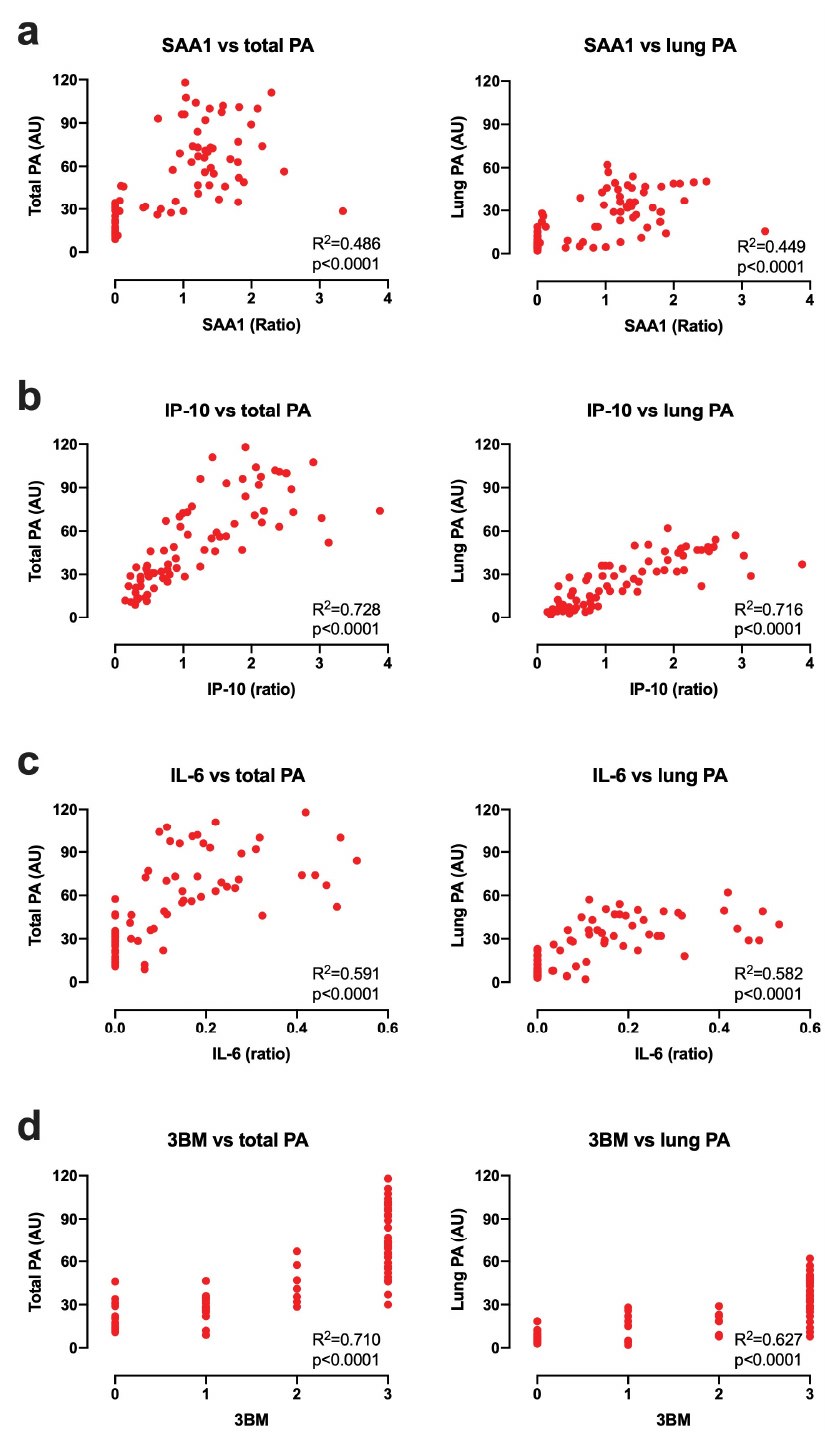
Figure 3. Correlation between SAA1, IP-10, and IL-6 levels and total/ lung pathology score at the endpoint. ( a ) SAA1, ( b ) IP-10, and ( c ) IL-6 levels ( x -axis) were measured by UCP-LFA in serum from MTB Erdman infected rhesus macaques ( n = 75, see Figure 1). Tuberculosis pathology (PA; y -axis) scoring methods are described in Materials and Methods (2.2), and PA is expressed as arbitrary units (AU). R 2 is the square of the Spearman correlation coefficient. ( d ) Values above the cutoff per biomarker (described in Table 1b) were considered positive. 3BM ( x -axis) was generated using the sum of all positive tests results from the individual markers. ( a – d ) SAA1, IP-10, IL-6, and 3BM showed a good correlation with total- and lung pathology scores at the endpoint.